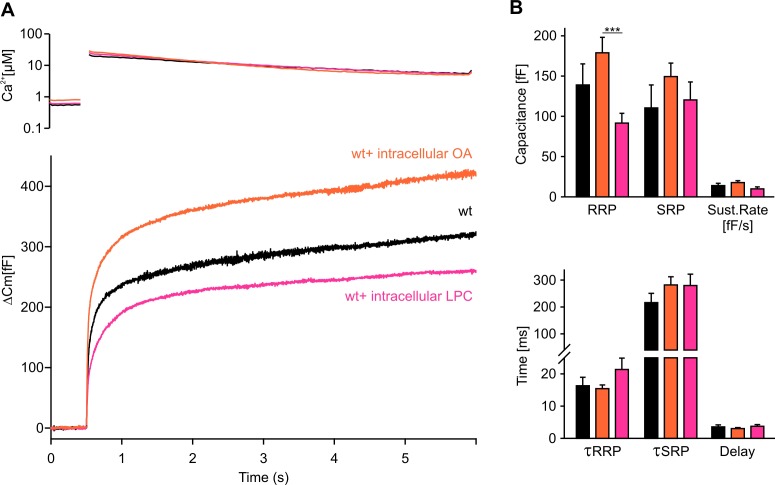
Intracellular application of LPC or OA affects synchronous secretion.(A) Mean flash-induced [Ca2+]i levels (top panel) and corresponding CM responses (lower panel) of wt cells with intracellular LPC or OA application (5 µM). Intracellular LPC and OA oppositely affect the flash-evoked response. While LPC reduces total secretion, OA enhances it. (B) The RRP size is significantly larger in OA-treated cells compared with LPC cells (upper panel). No significant difference was detected for either group versus wt (RRPOA versus RRPWT, p=0.338; RRPLPC vs. RRPWT, p=0.199) Neither the kinetics of release τRRP and τSRP, nor the secretory delay is changed in both conditions (lower panel). Arrow indicates UV-flash. Data are represented as mean ± SEM and were collected from the following numbers of cells: wt (n = 8), wt+intra-OA (n = 13), wt+intra-LPC (n = 16). ***p<0.001, one-way analysis of variance followed by Tukey-Kramer post test.